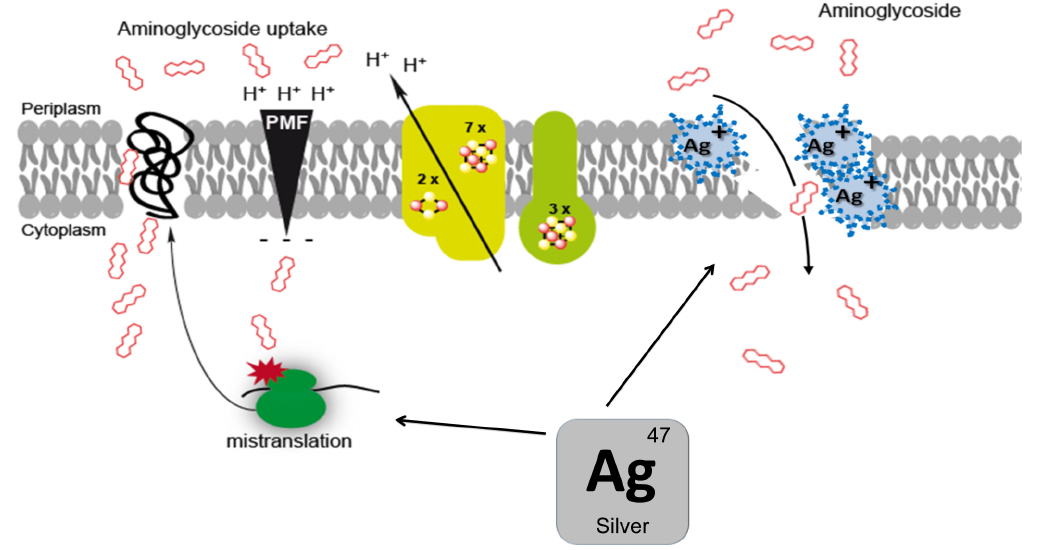
Figure 4. A molecular mechanism model for aminoglycoside and silver synergy. Silver enhances aminoglycoside toxicity by enhancing their uptake. Silver could destabilise the membrane either directly by altering intrinsic membrane proteins or indirectly by acting on ribosomes, which would produce misfolded aborted polypeptides that would eventually go to the inner membrane. Increased permeability of membrane would provoke massive aminoglycoside